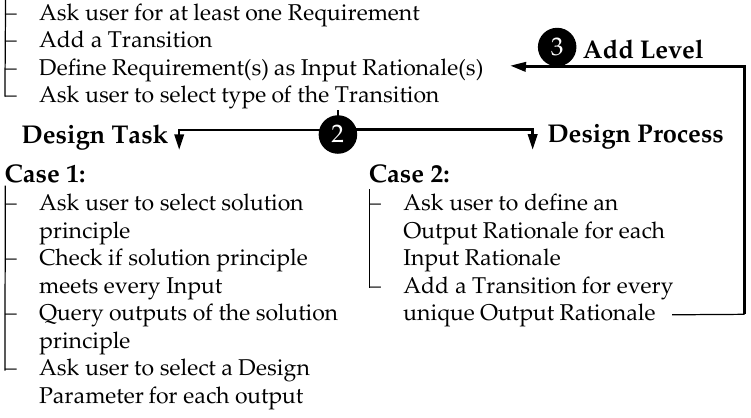
Figure 5. Illustration of the Annotation Process for